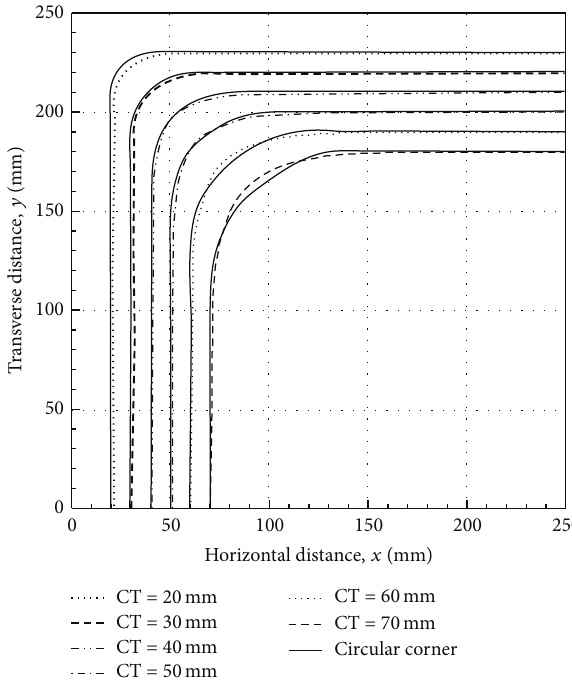
Figure 10: Isoconcentration contours with a value of the CTL for various values of concrete cover thicknesses. Circular fillets of the inner concrete cover corners, each with a radius equal to the value of CT, are overlaid. Square, 500 mm by 500 mm,